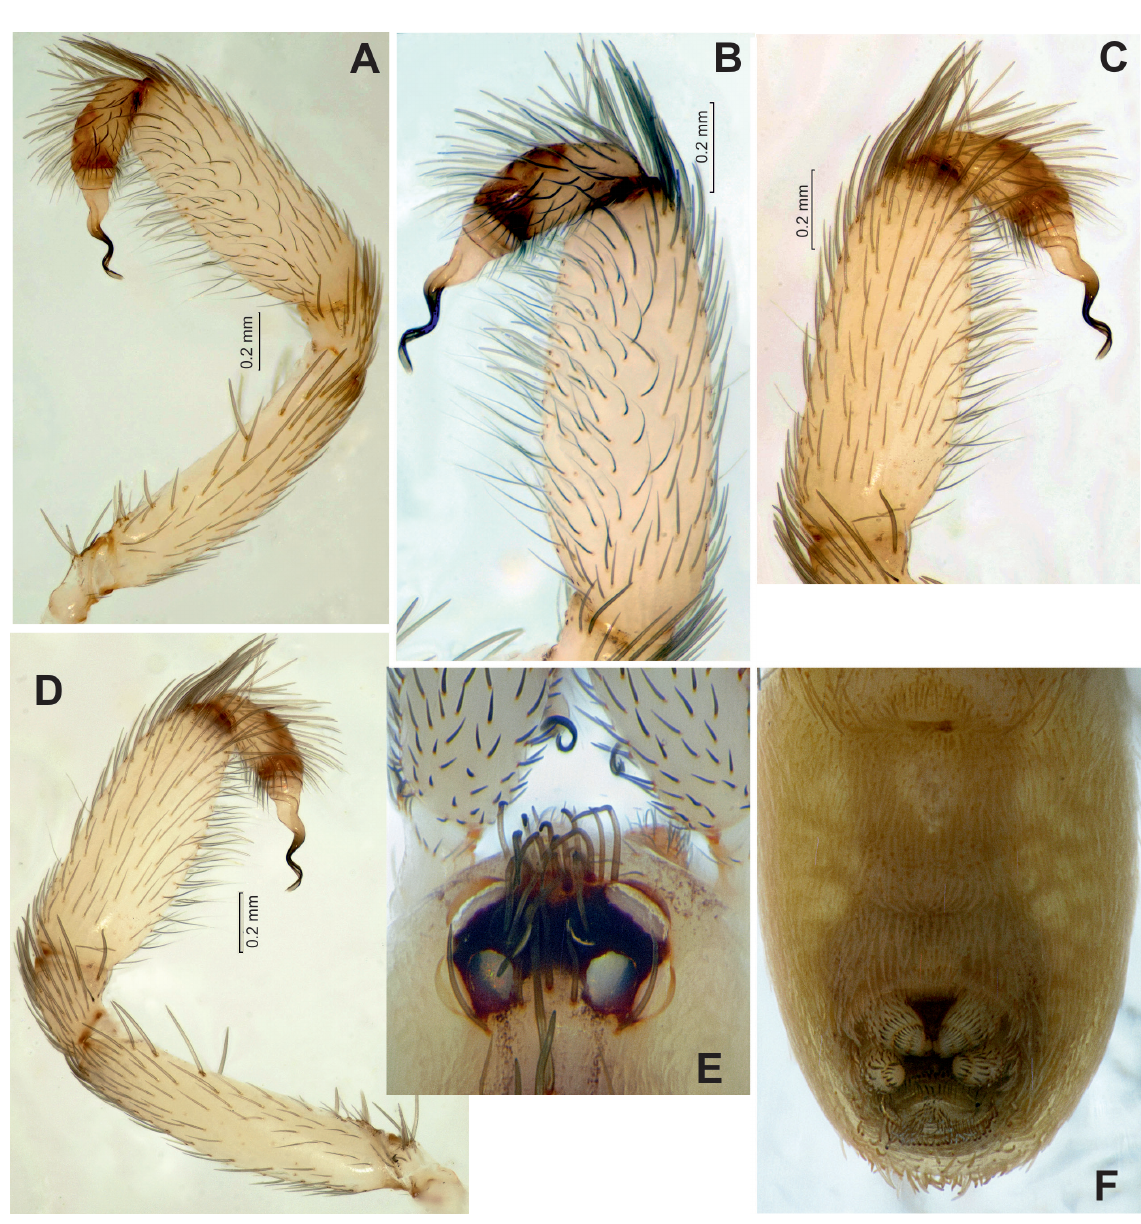
Fig. 25. Palp and somatic characters of Zaitunia martynovae (Andreeva & Tyshchenko, 1969), ♂ from Gandzhina. A , D . Palp, retro- and prolateral. B–C . terminal part of palp, retro-ventral and prolateral. E . Cephalic part of carapace, dorsal. F . abdomen,